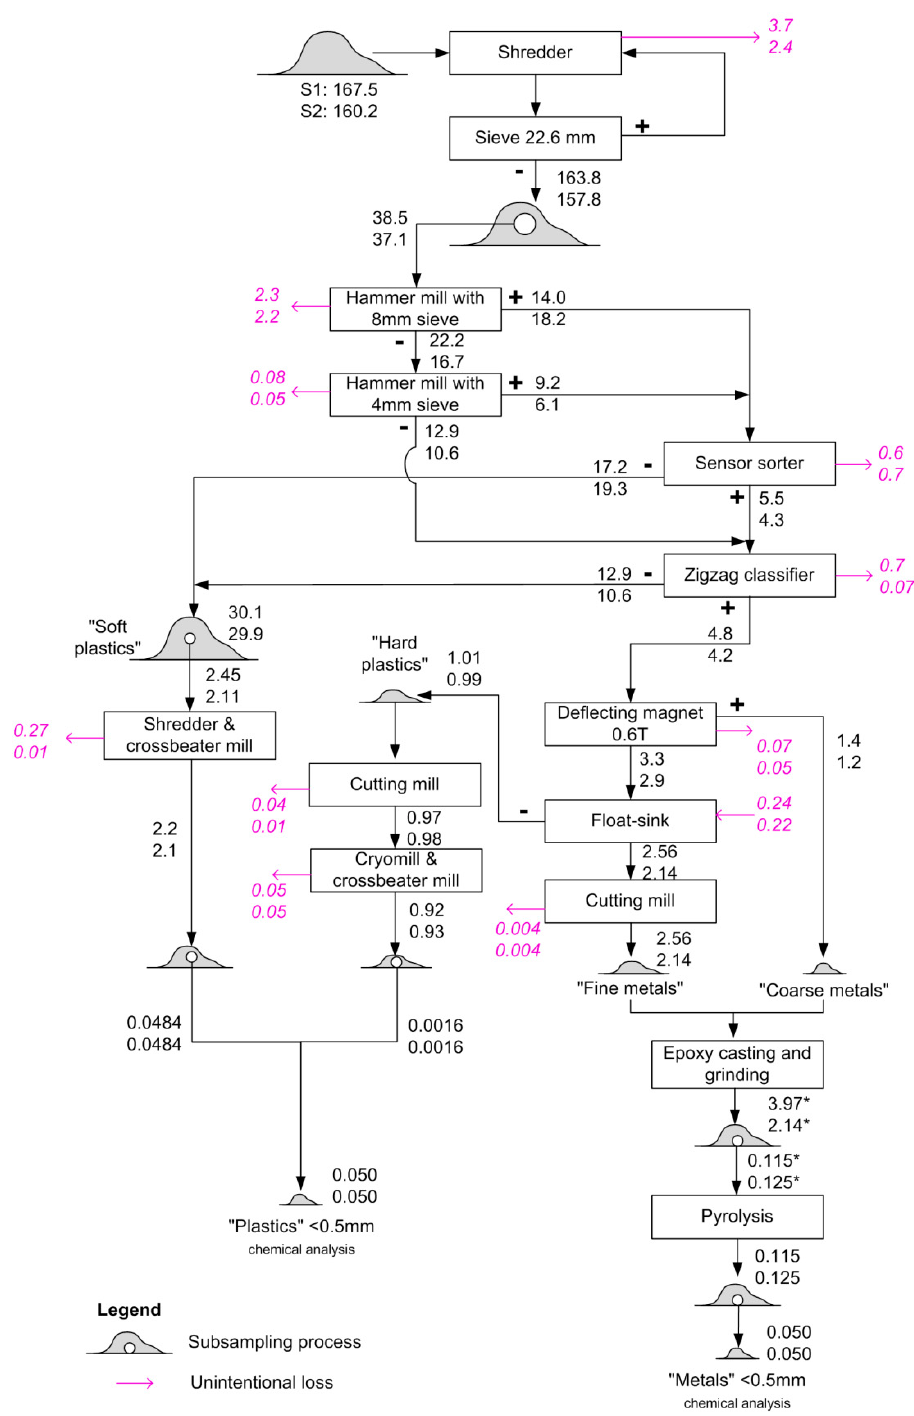
Figure 1. Mechanical sample preparation process for SLF. The numbers refer to the related mass flows in kg from sample S1 (top) and S2 (bottom). Magenta arrows indicate unintentional losses, determined by weighing the inputs and outputs of each operation. The numbers marked with an asterisk (*) refer to the “metals” content excluding the added epoxy.